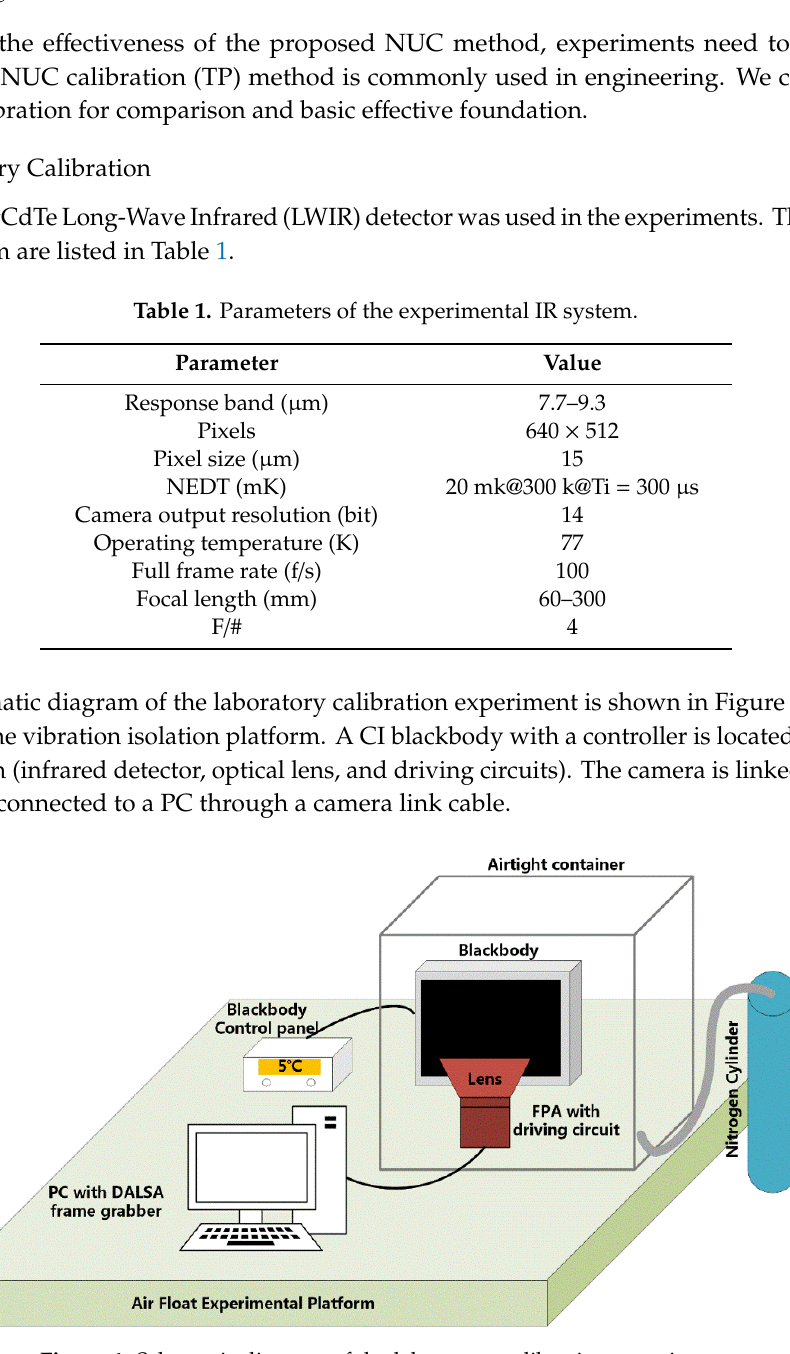
Table 1. Parameters of the experimental IR system.